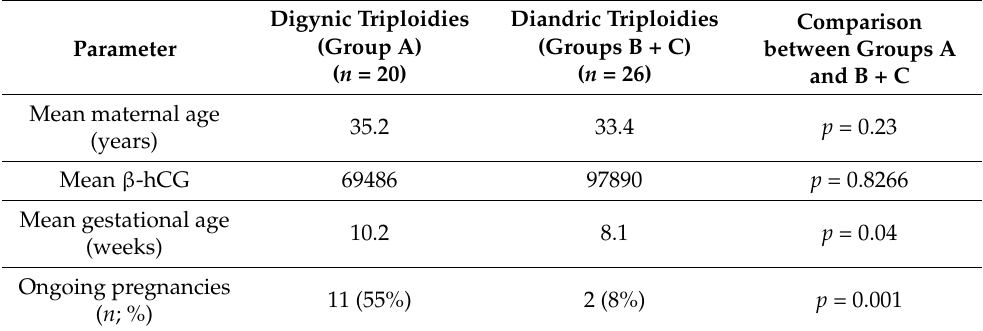
Table 1. Pregnancy characteristics and pathology studies in the 20 digynic and 26 diandric triploidies.